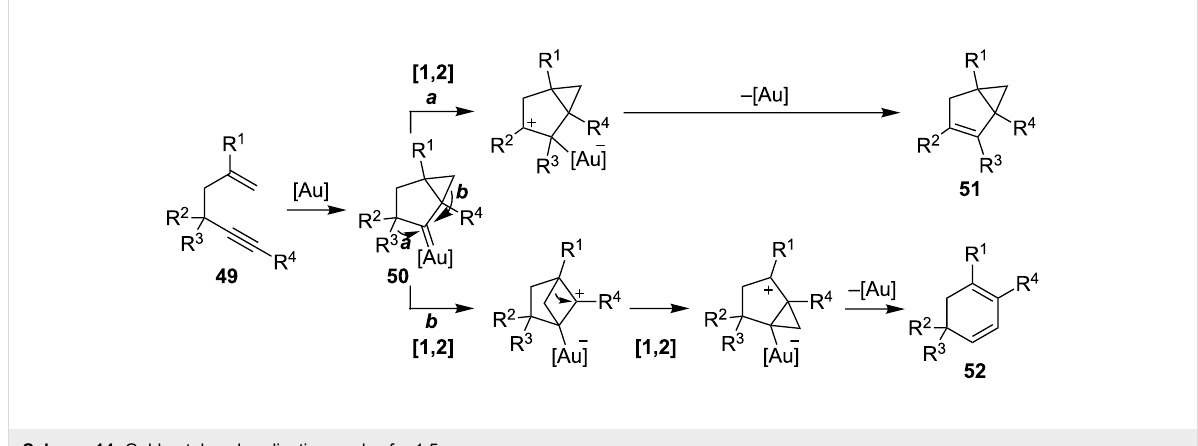
Scheme 14: Gold-catalyzed cyclization modes for